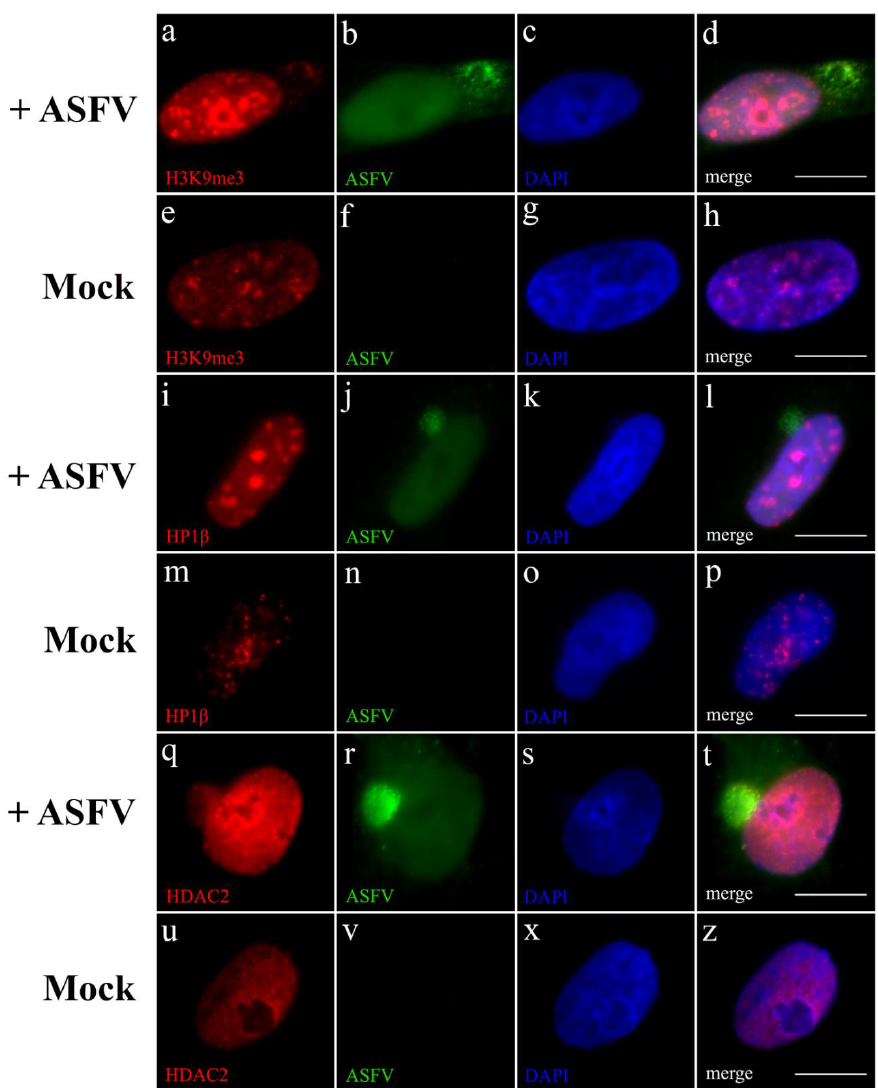
Figure 4. ASFV modifies the host chromatin state. Immunofluorescence analysis was performed on non-infected and ASFV-infected Vero cells (8 hpi) using specific antibodies recognizing heterochromatin marks—H3K9me3, HP1 β and HDAC2 (red) and viral proteins (green). Cell nuclei were counterstained with DAPI (blue). ( a – d ) Histone H3 trimethylated at lysine 9 (H3K9me3, red) show large accumulations throughout the nucleoplasm upon ASFV infection (green), not observed in uninfected cells ( e – h ). ASFV-infected cells (green) also present HP1 β (red) nucleoplasmic accumulations ( i – l ), not detected in non-infected cells ( m – p ). HDAC2 (red) is the only member of HDACs family that displays a more intense nuclear labelling in ASFV-infected cells (green), and additional recruitment to viral cytoplasmic factories ( q – t ), when compared to non-infected cells ( u – z ). Scale bar, 10 μm. Representative microscopy images of at least three independent experiments are shown.